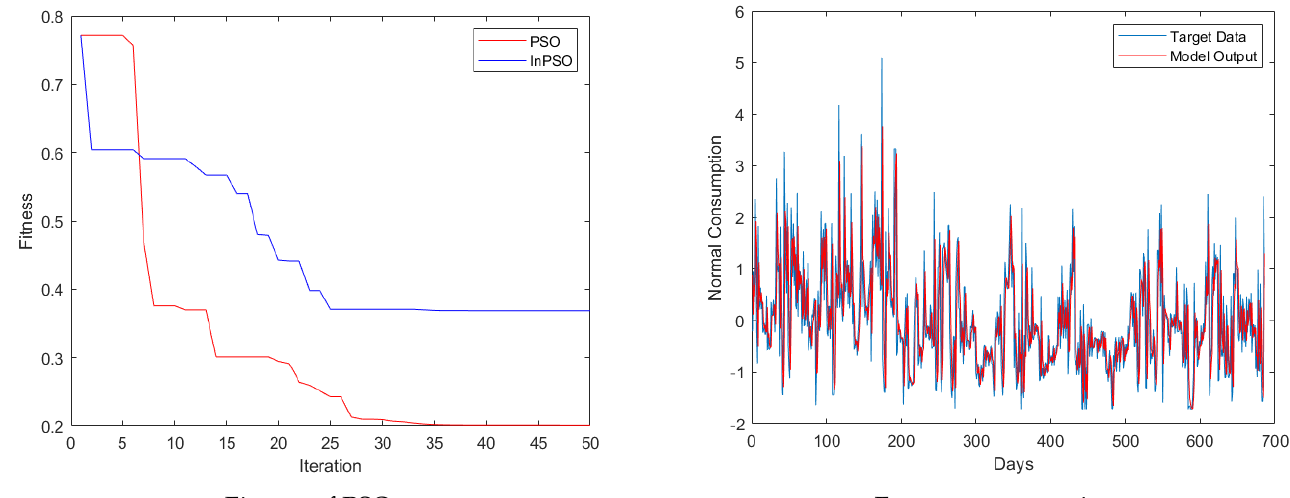
Figure 5. Predictions based on DNFW for energy consumption in Tehran.